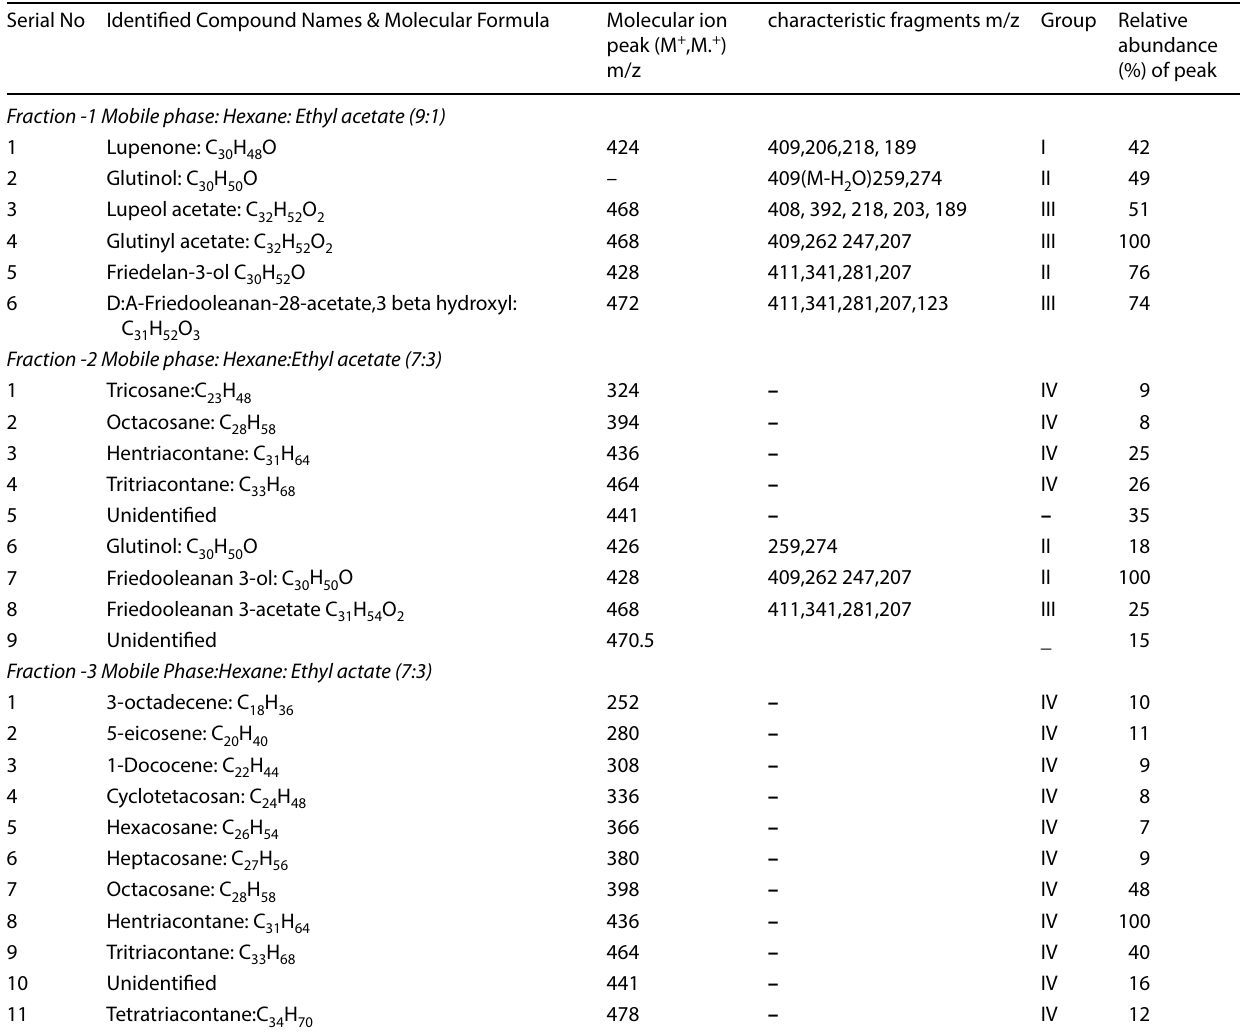
Table 3 Euphorbia milii leaf wax constituents identified from GC–MS studies Serial No Identified Compound Names & Molecular Formula Molecular ion